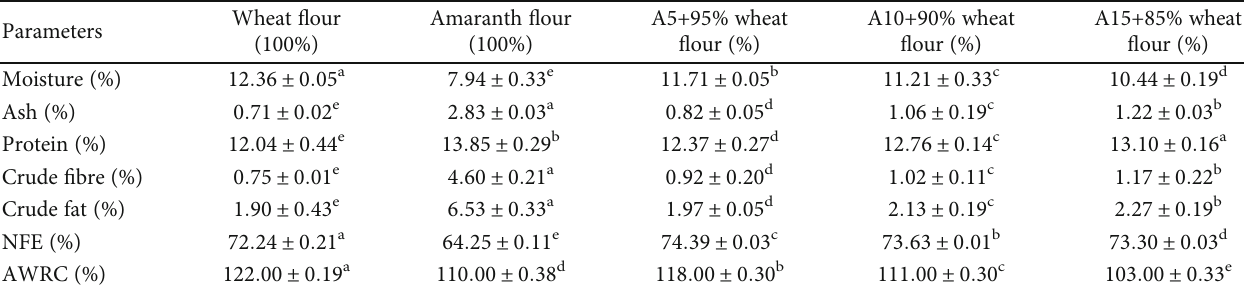
Values are expressed as means of triplicate samples ± standarddeviation ( n = 3 ). Values with the same superscripts in a column are statistically similar while values with di ff erent superscripts are signi fi cantly di ff erent ( p ≤ 0 : 05 ). Table 3: Antioxidant activity of wheat fl our (WF), amaranth fl our (AF), and mixtures. Wheat fl our Amaranth fl our Parameters (100%)